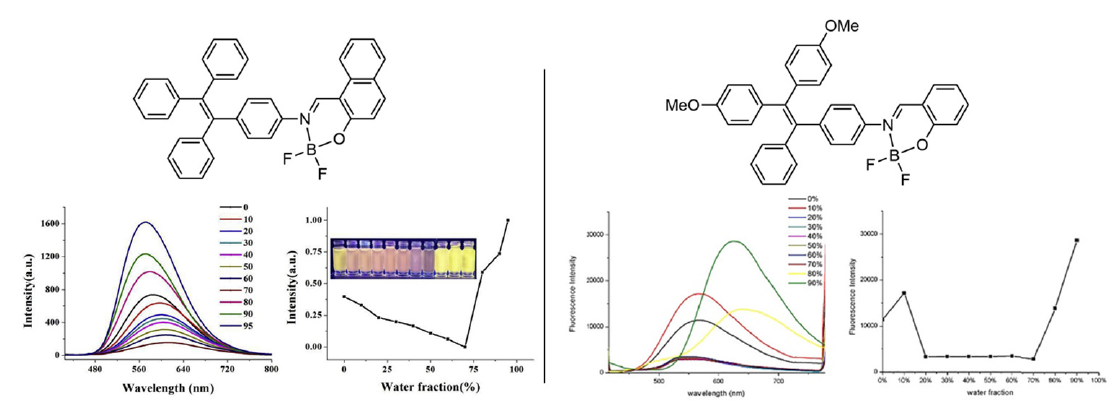
Figure 5. Examples of boranils dyes displaying Aggregation-Induced Emission (AIE) or Aggregation-Induced Enhanced Emission (AIEE) [50,51]. Adapted from Reference [50]. Copyright 2019 Elsevier. Adapted from Reference [51]. Copyright 2018 Elsevier.